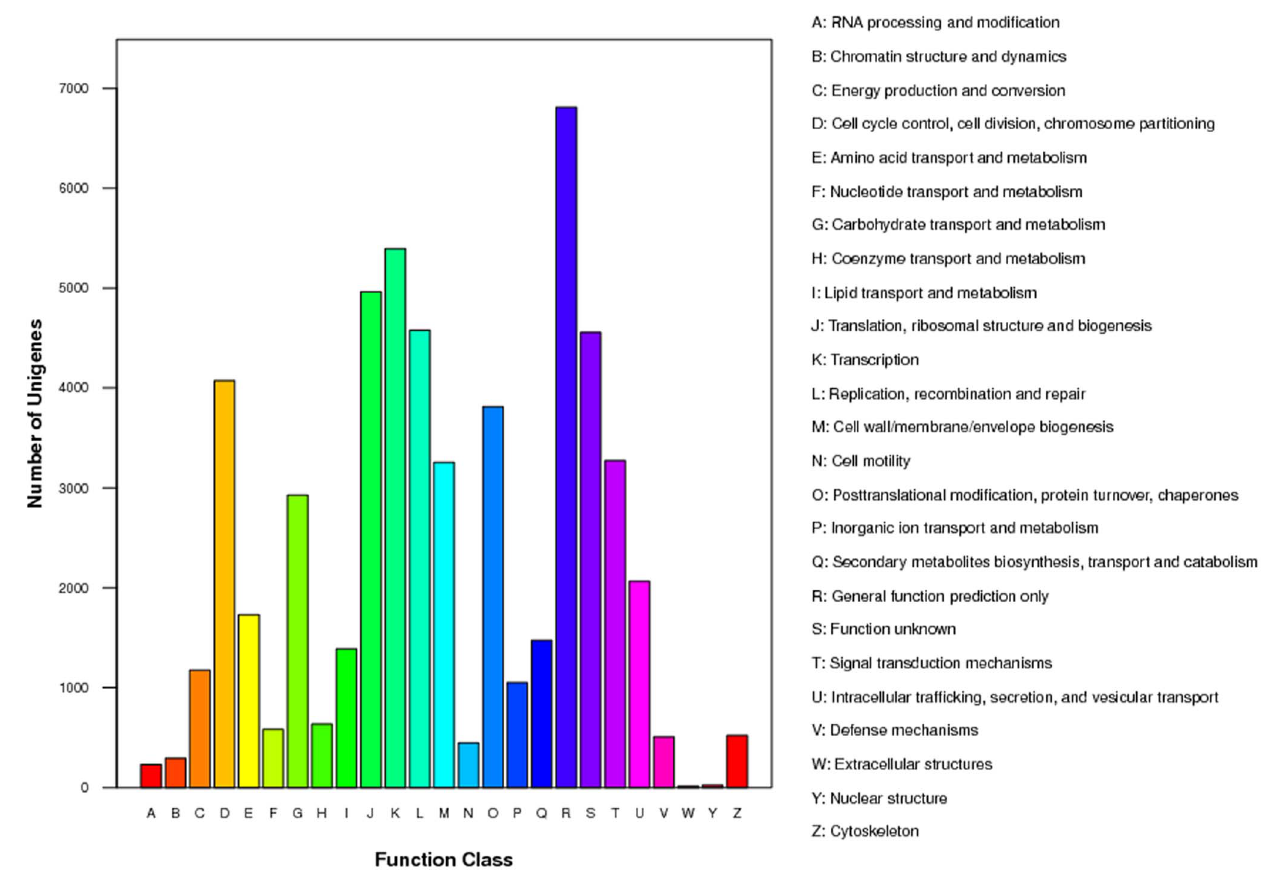
Figure 3. COG function classification of Unigenes. doi:10.1371/journal.pone.0095428.g003 PLOS ONE |